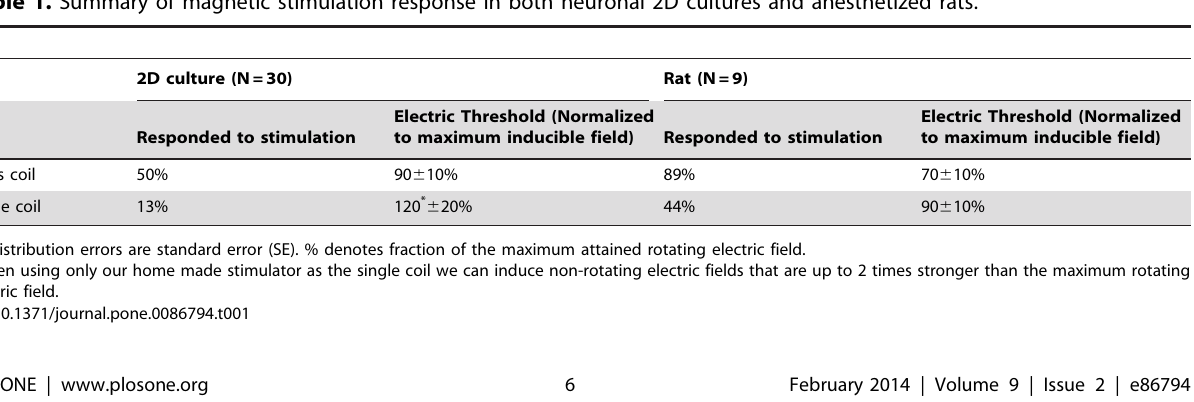
Table 1. Summary of magnetic stimulation response in both neuronal 2D cultures and anesthetized rats.